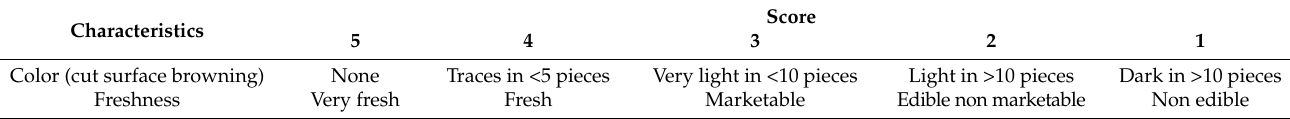
Table 1. Quality assessment scoring system for fresh-cut purple